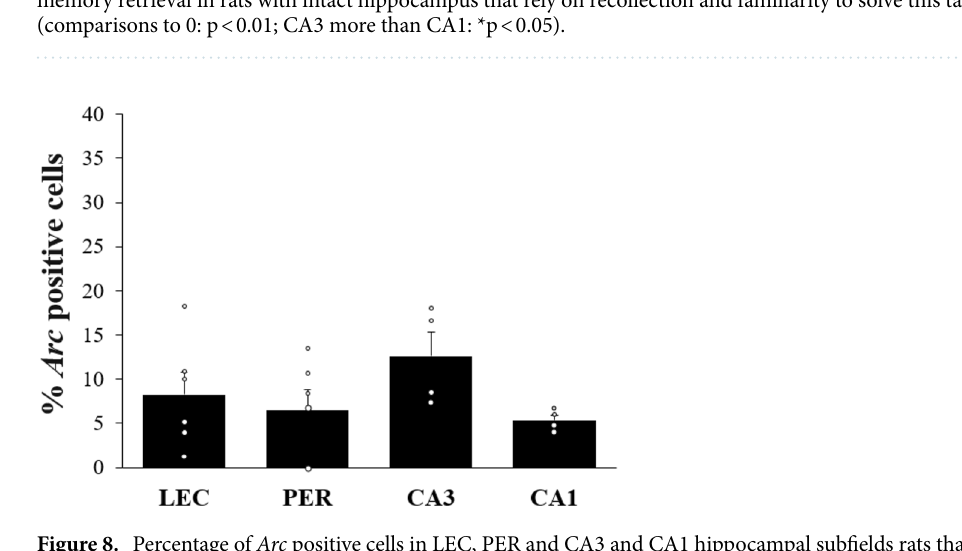
Figure 8. Percentage of Arc positive cells in LEC, PER and CA3 and CA1 hippocampal subfields rats that did not perform the task (means ± SEM). Baseline Arc RNA expression in MTL areas was low (all comparisons to 0: p < 0.05) and comparable between areas in the home-caged